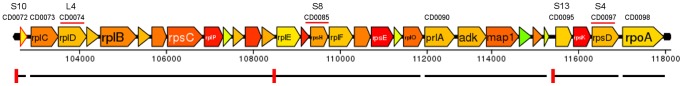
Organisation of the S10-spx-α region in the genome of Clostridium difficile strain 630.Black line: Biocyc predicted transcriptional units. Red boxes: Location of autogenous RNA regulatory structures in Escherichia coli. Orange underscore: protein with predicted regulatory function.